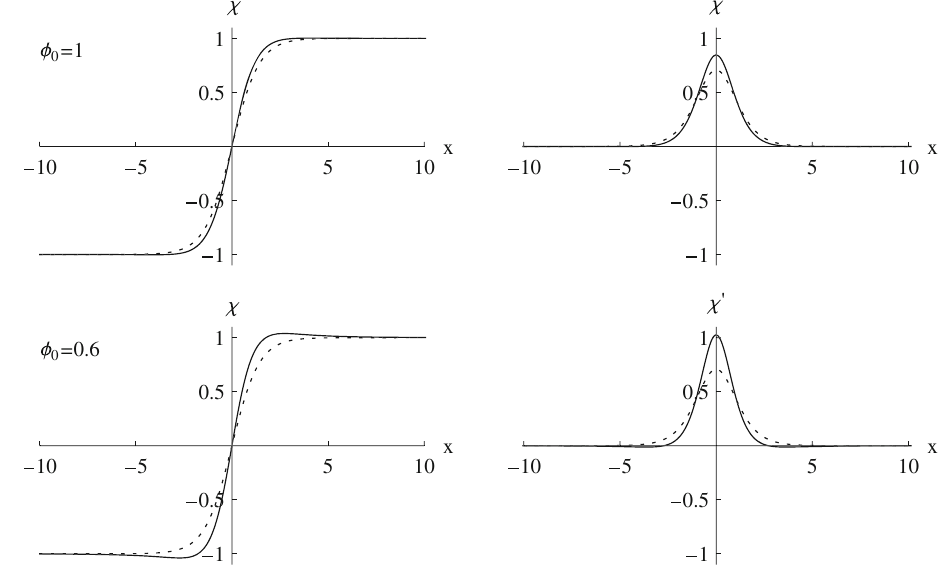
Fig. 7 The bosonic field and its derivative with respect to x corresponding to negative energy for φ 0 = 1 and φ 0 = 0 . 6. Solid and dashed curves depict the bosonic field and its derivative in the dynamical and background models,